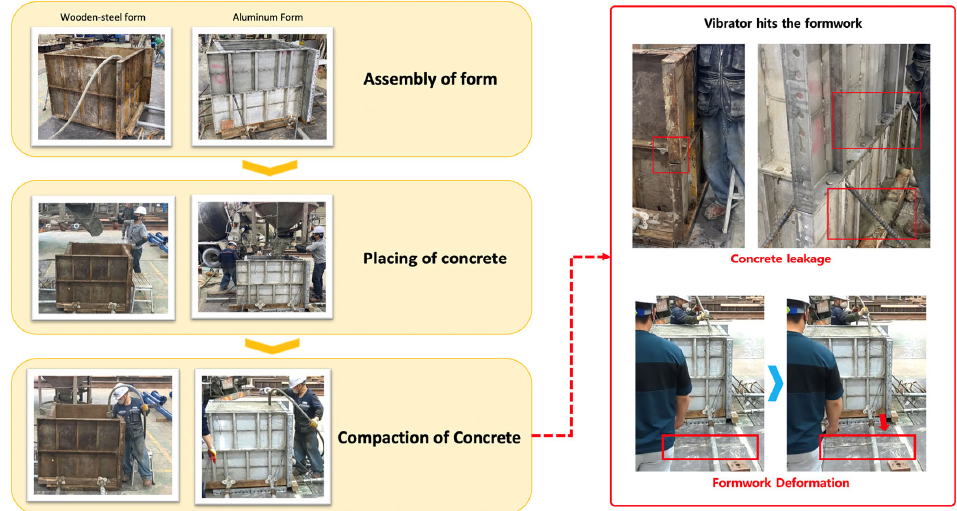
Figure 3. Experiments for formwork impact sound data collection.